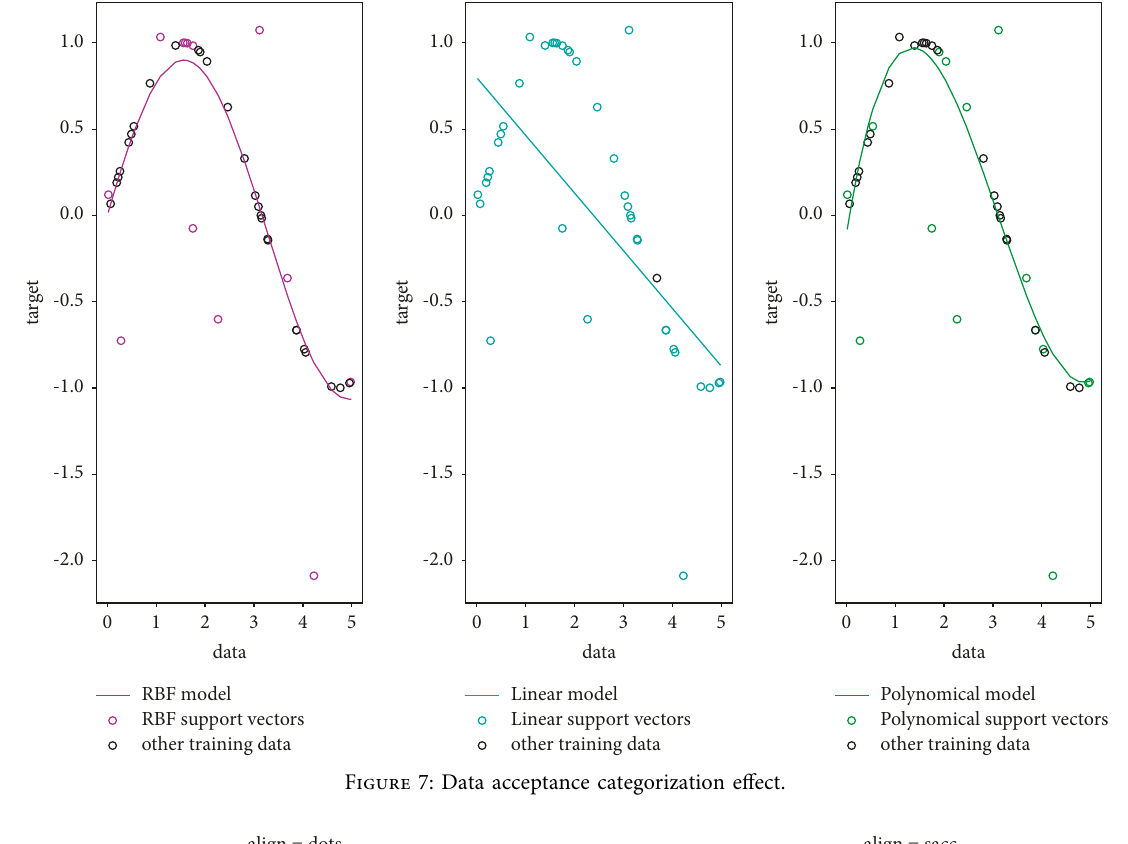
Figure 7: Data acceptance categorization effect.